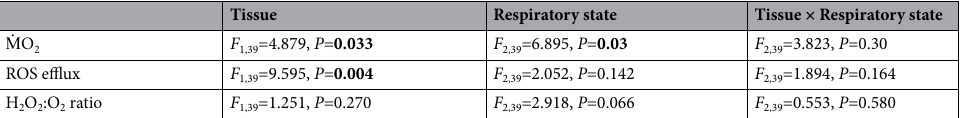
Table 1. ANOVA: Effects of tissue type and respiratory states (LEAK I, LEAK I+II, OXPHOS) on the oxygen consumption rates ( Ṁ O 2 ), ROS efflux and H 2 O 2 :O 2 ratio of permeabilized muscle and brain cells under the control (normoxic) conditions. F values with the degrees of freedom for the effect and error (in subscripts) are shown. Significant P values ( P <0.05) highlighted in bold.